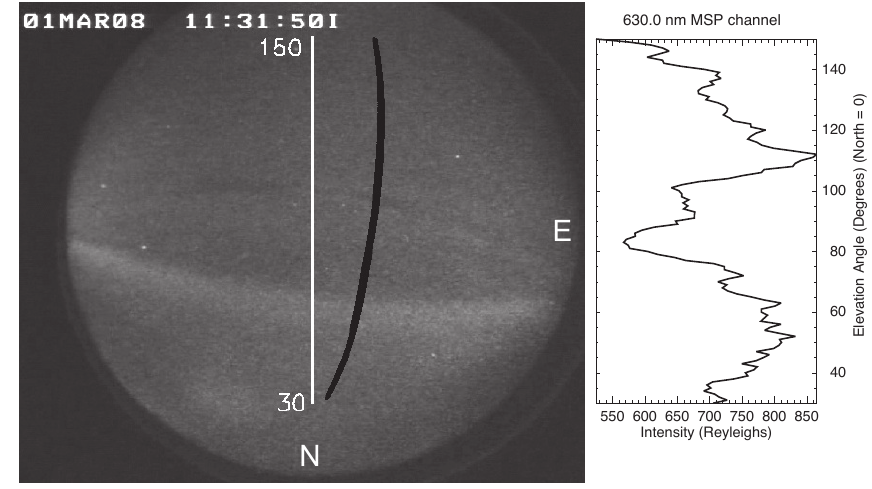
Fig. 5. All-sky image from 1 March 2008, showing the location of the MSP scan and the path of the Reimei footpoint. The line plot on the right shows the intensity of the 630.0nm emissions, as a function of position along the